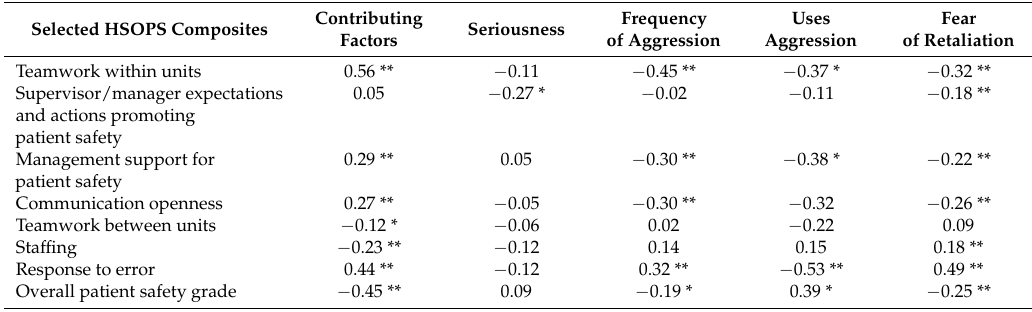
Table 2. Spearman’s correlations between selected hospital survey on patient safety culture composites and negative behaviors in healthcare